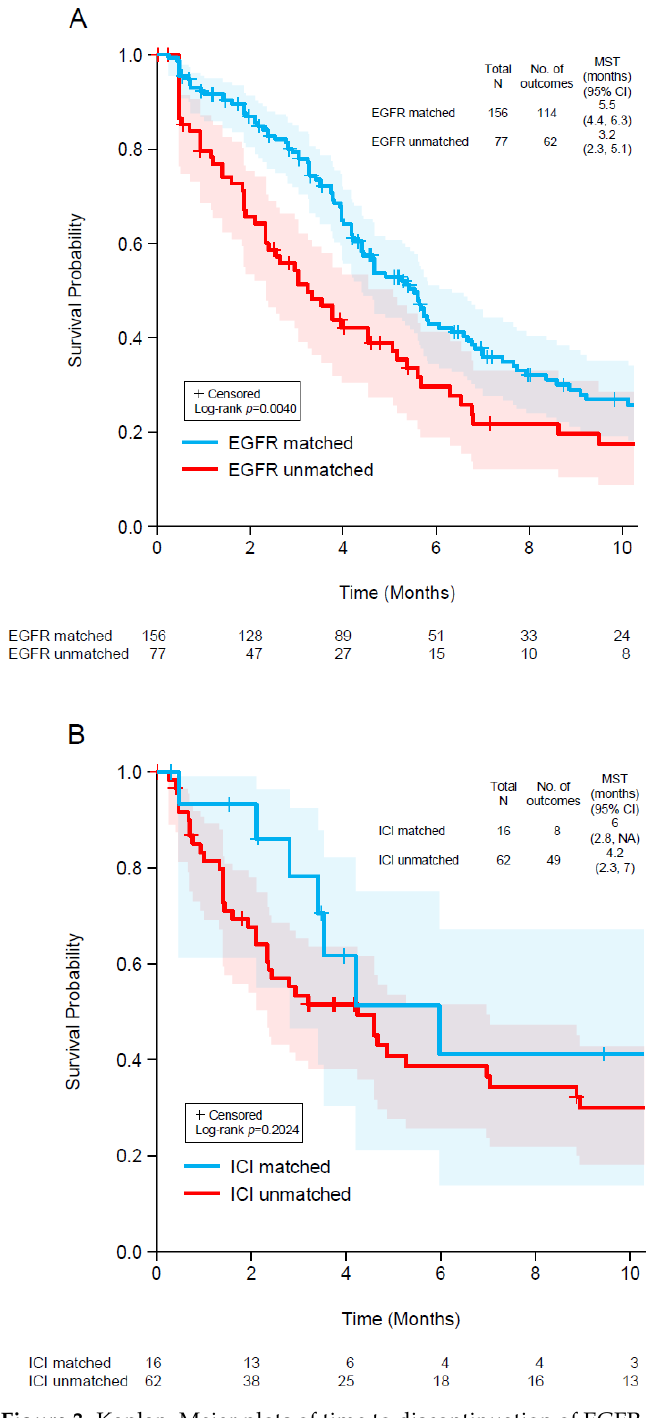
Figure 3. Kaplan–Meier plots of time to discontinuation of EGFR-targeted therapy ( A ) and immune checkpoint inhibitor therapy ( B ) in two groups: (1) patients with a clinically actionable genomic profile who received matched targeted therapy (blue) and (2) patients whose genomic profile did not support the therapy used. The shaded regions indicate 95% confidence intervals. CI, confidence interval; EGFR, epidermal growth factor receptor; ICI, immune checkpoint inhibitor; MST, median survival time.